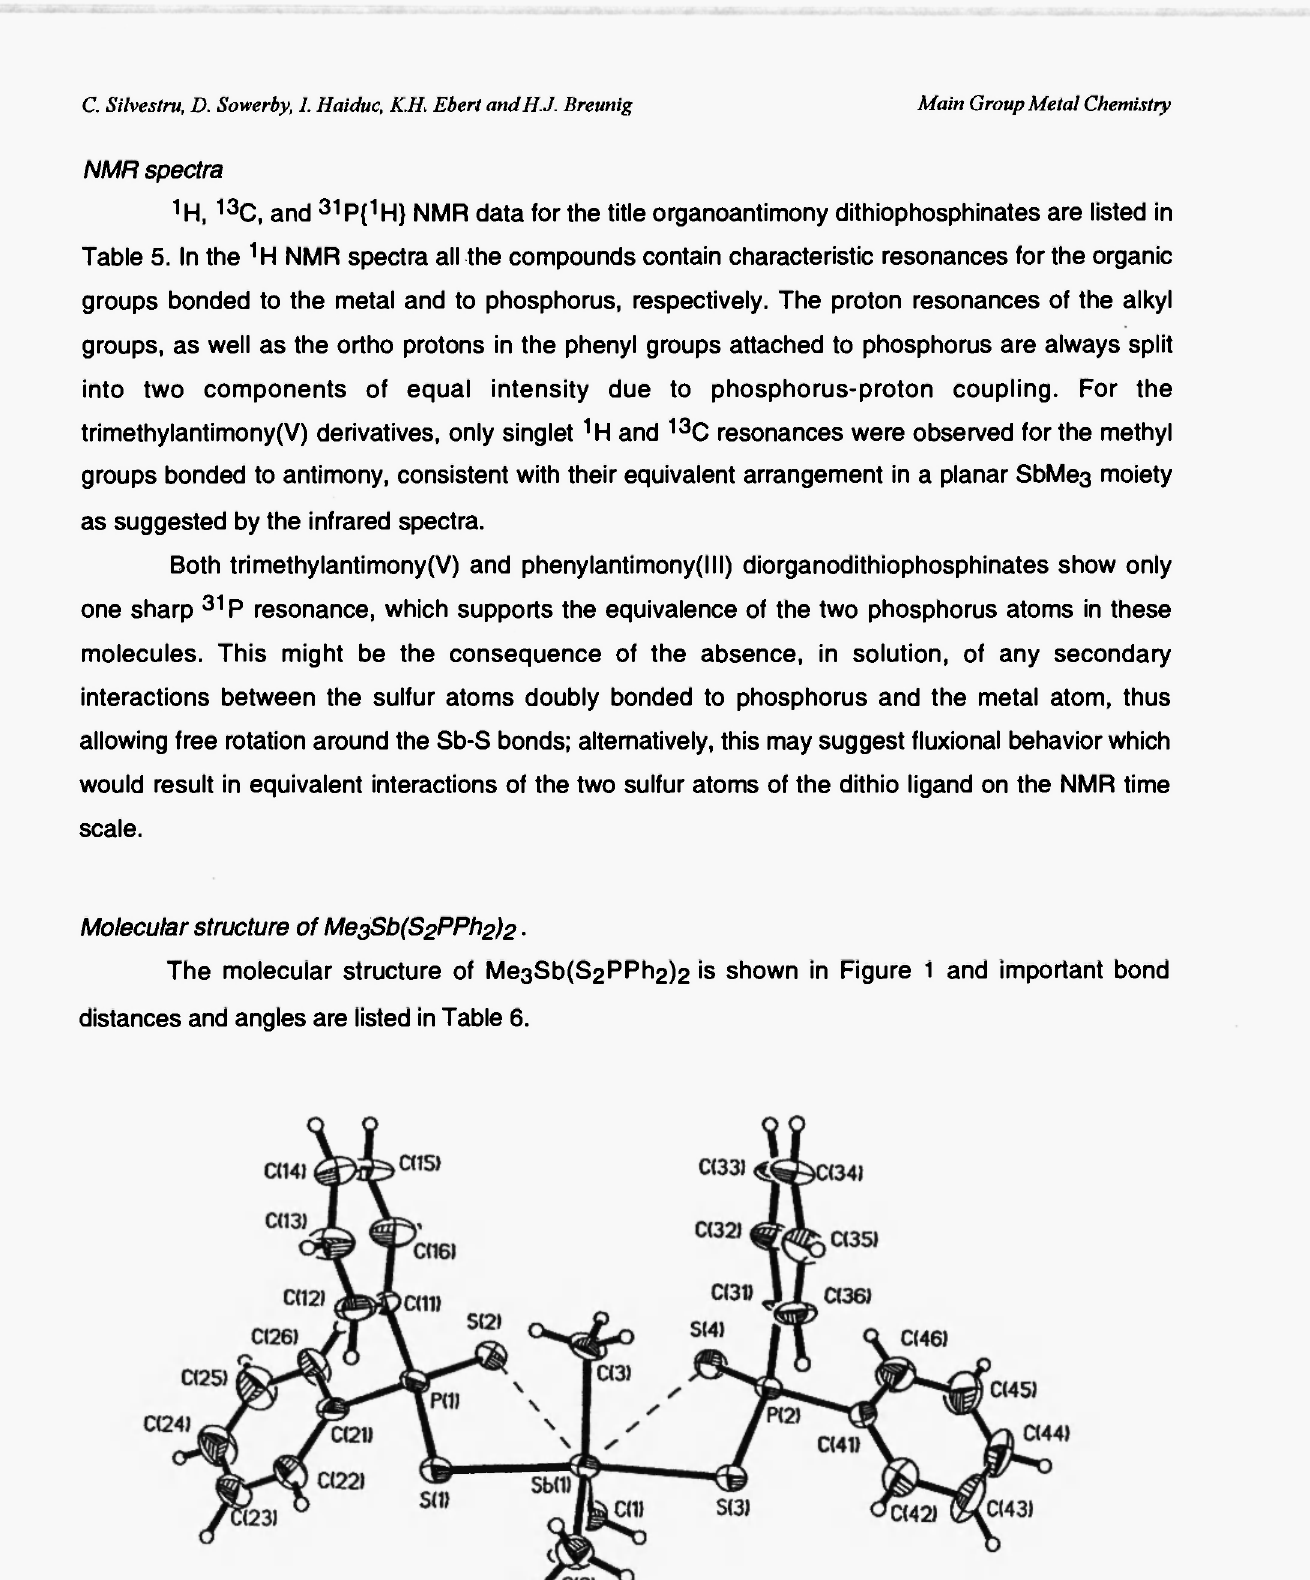
Figure 1 . ORTEP drawing of the monomeric structure of